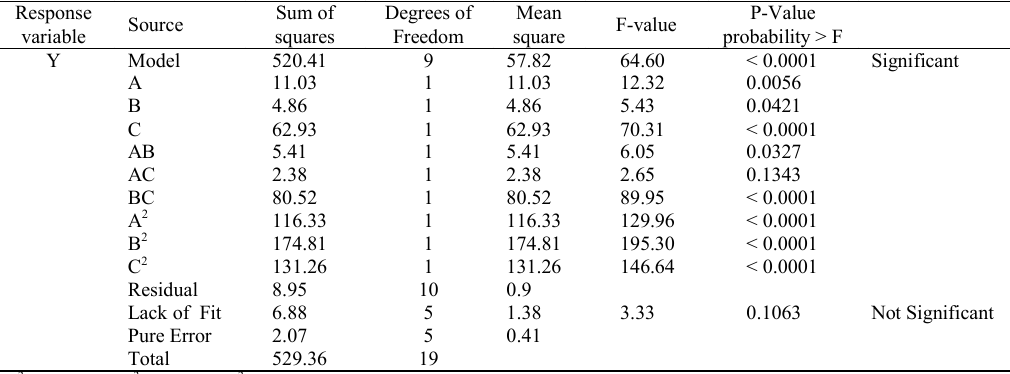
Table 3: Analysis of variance (ANOVA) for response